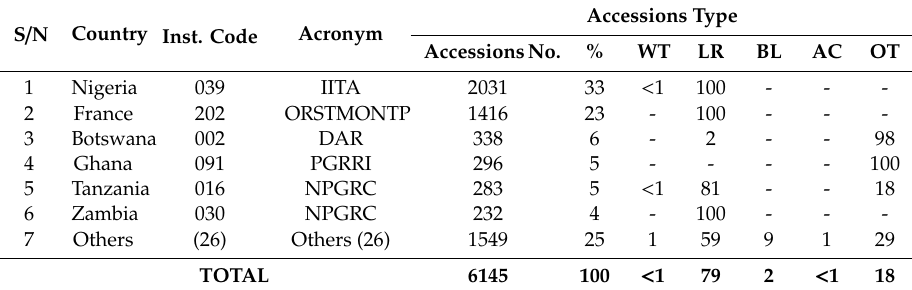
Table 1. Bambara groundnut landraces / accessions and wild-type genotypes held by international institutions across some selected countries. S / N Country Inst.